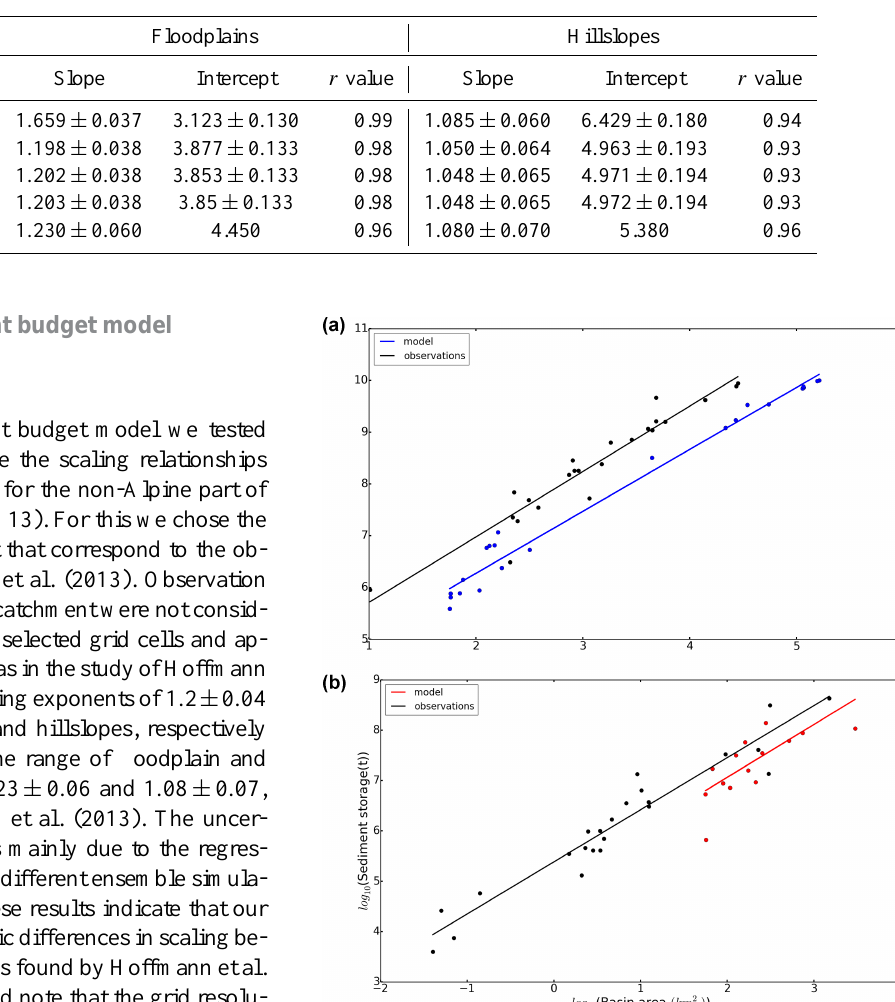
Figure 3. Scaling of floodplain (a) and hillslope (b) sediment stor- age from the transient simulation in the non-Alpine part of the Rhine catchment. The black dots and black trend line correspond to the observed sediment storage values from Hoffmann et al. (2013). The colored dots and colored trend line correspond to modeled sediment storage values that correspond to the observation points from Hoff- mann et al. (2013) and fall into the borders of the Rhine